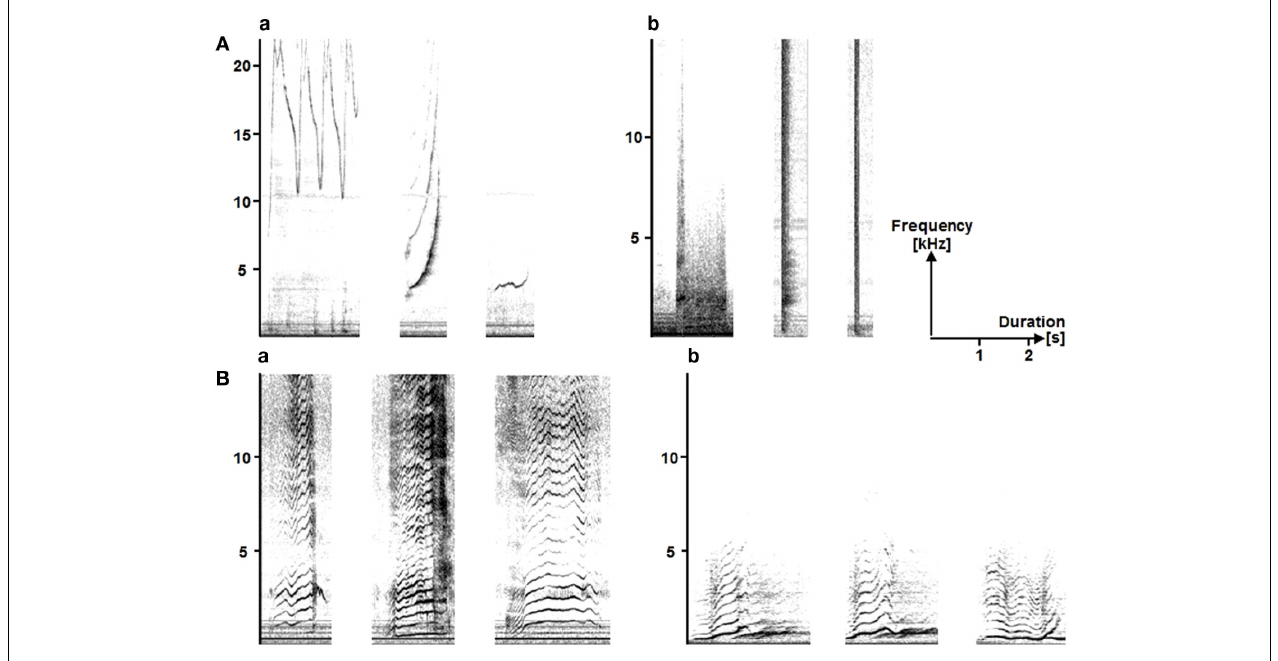
“model” humpback whales’ sounds. FFT: (Aa) 1024; (Ab) , (Ba) , and (Bb) 2282.The time axes for all spectrograms have been standardized; but the (Aa) frequency axis has been